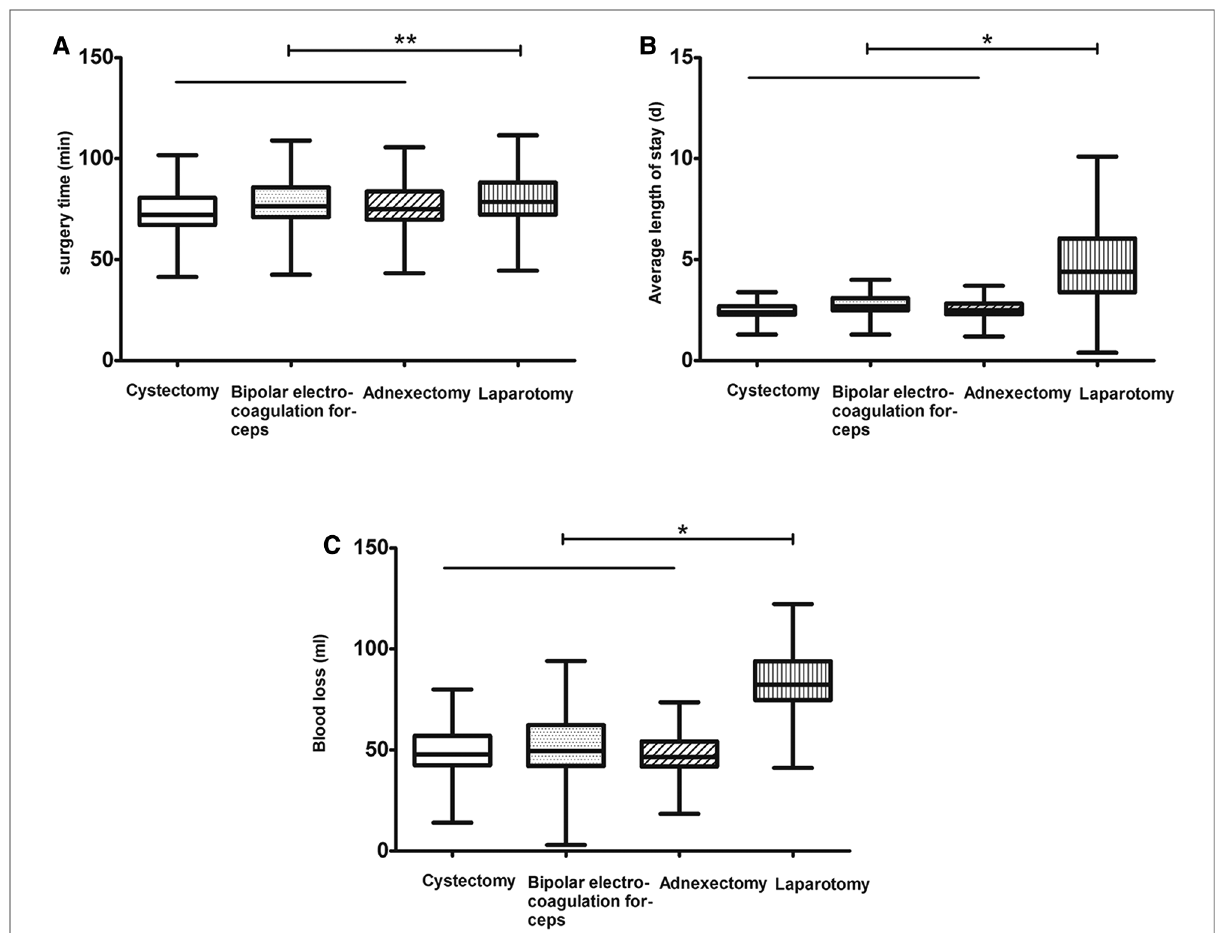
FIGURE 1 Features of operative time ( A ), average length of hospital stay ( B ), and blood loss ( C ) during the procedures. Cystectomy is indicated by a clear symbol, bipolar electrocoagulation forceps by a punctate symbol, adnexectomy by a slanted symbol, and laparotomy by a vertical symbol. *indicates P <0.05 and **indicates P